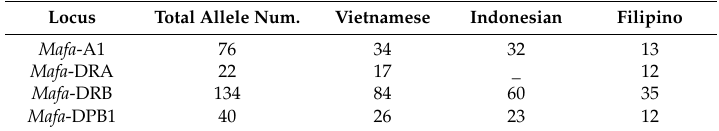
Table 3. Example of inter-population comparison based on MHC polymorphism. Locus Total Allele Num. Vietnamese